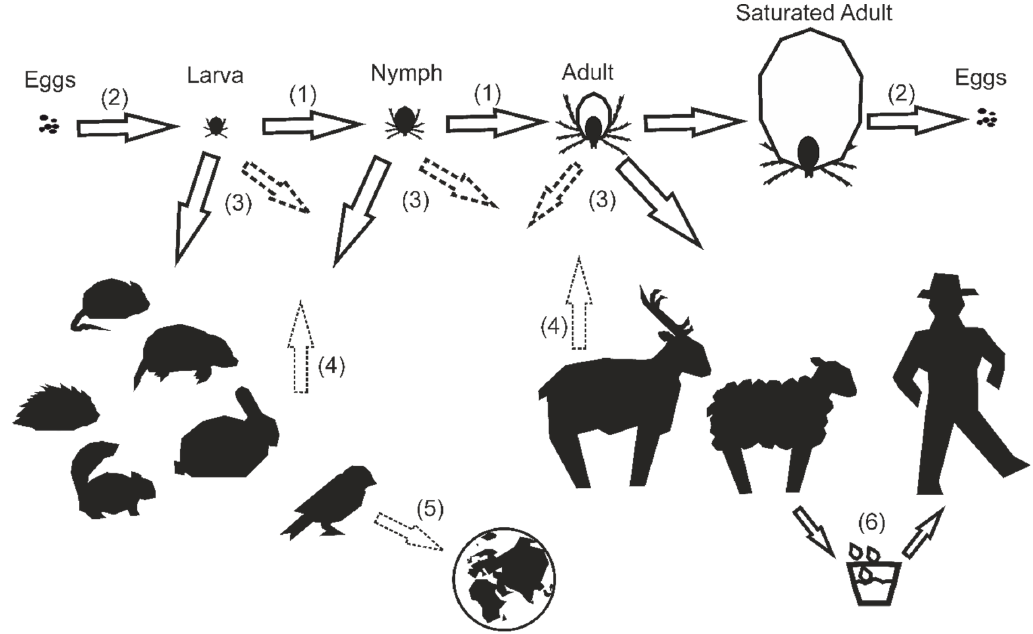
Figure 1. Transmission routes of tick-borne encephalitis virus (TBEV): Infected ticks pass the virus to a variety of small and large animals, as well as humans ( 3 ). Each stage has a preference for certain animal groups ( ), but can be found in a variety of animals (